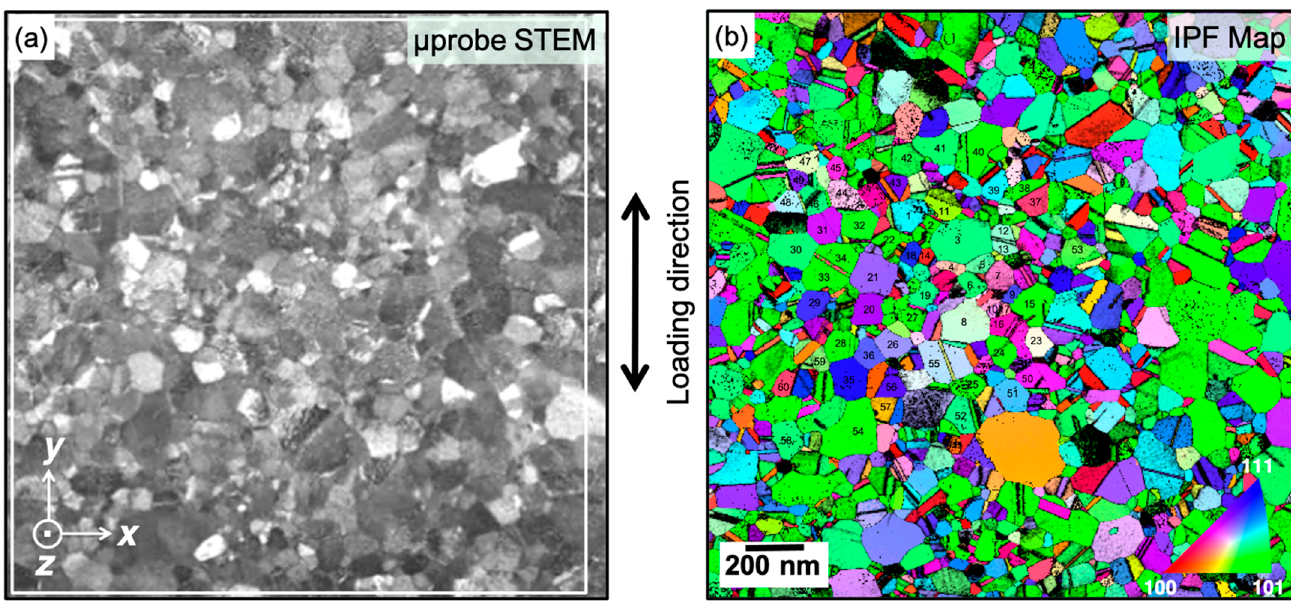
Figure 2. ( a ) µ P-STEM image and ( b ) inverse pole figure (IPF) map along the loading direction acquired using ACOM-STEM. The grains analyzed are numbered as reference for further analysis.